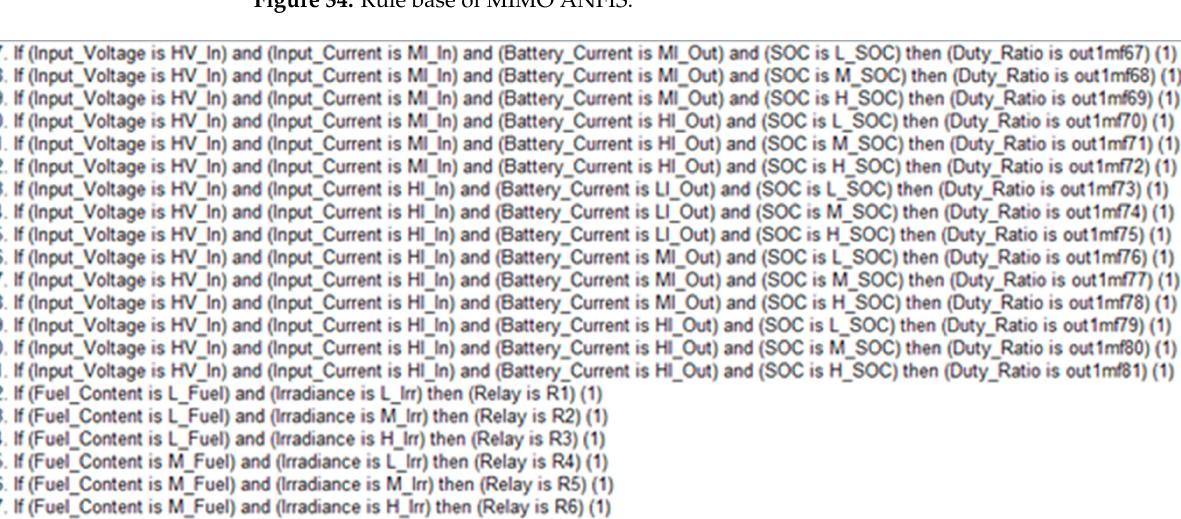
Figure 35. Rules generated by grid partitioning of MIMO ANFIS.